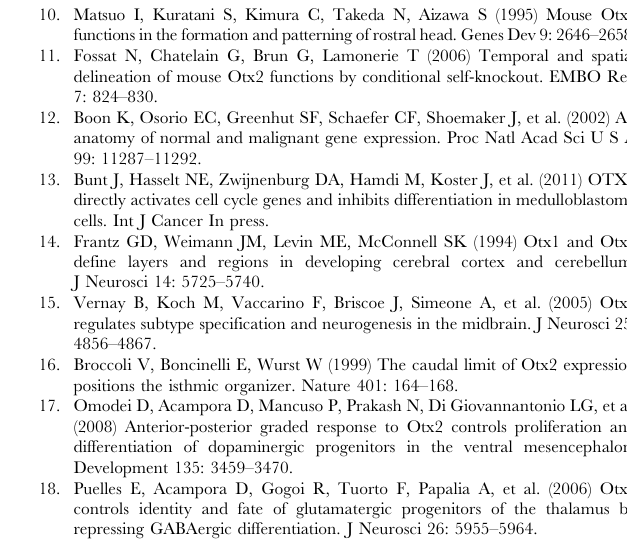
Figure S1 Generation of Lox-stop-lox-Otx2 knockin mice. (A) ROSA26 locus (top) and pROSA26-CAG-lox-stop-lox-OTX2 targeting construct (below). ‘‘Probe’’ indicates location of probe for Southern blot. (B) Southern blot of EcoRV-digested genomic DNA from three representative ROSA26 Lsl-OTX2/ + ES cell clones